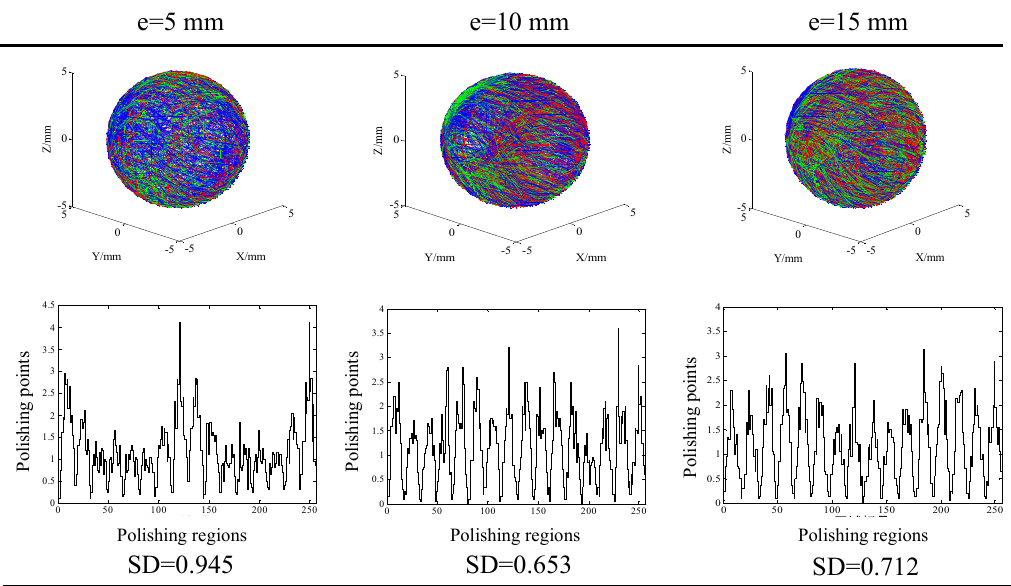
Figure 10. Distribution of the finishing traces at different rotating ratios when eccentricity and machining gap were fixed ( e = 10 mm, δ = 0.8 mm).